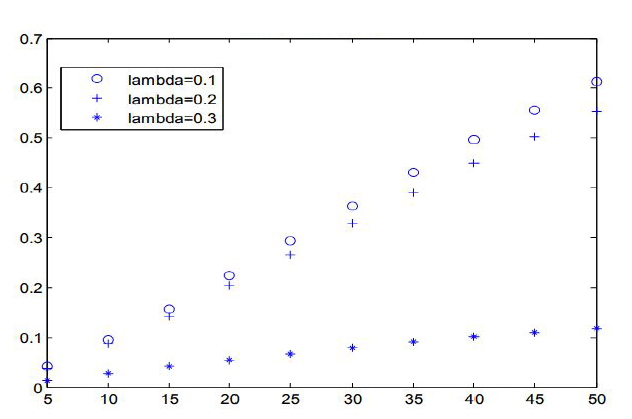
Figure 1. Relative change of estimate of β against d